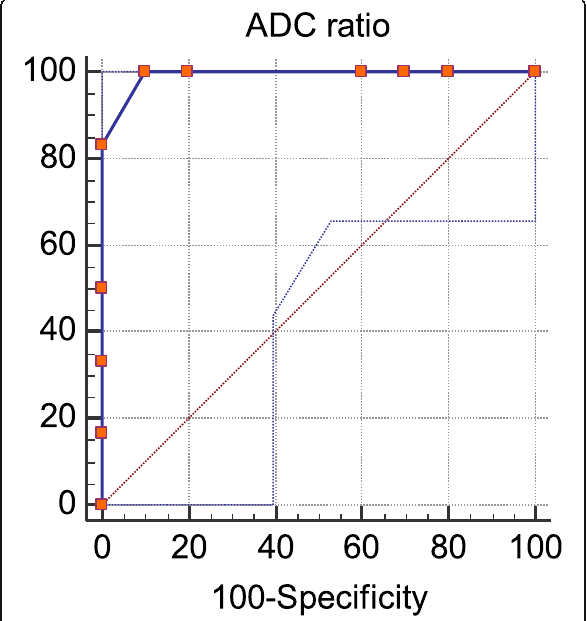
Fig. 11 ROC curve illustrates AUC, sensitivity, and specificity of